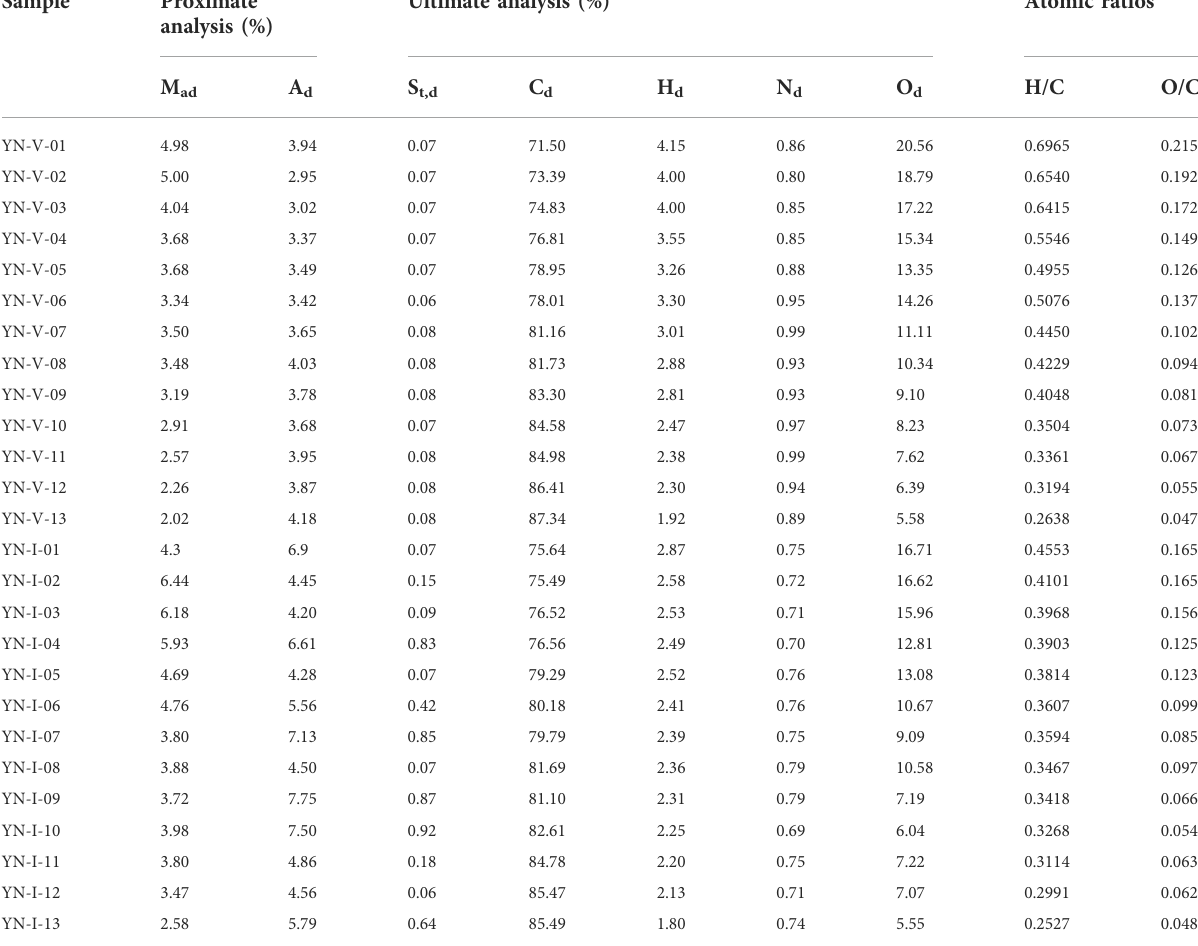
TABLE 4 Results of proximate and ultimate analysis of thermally simulated vitrinite and inertinite samples.